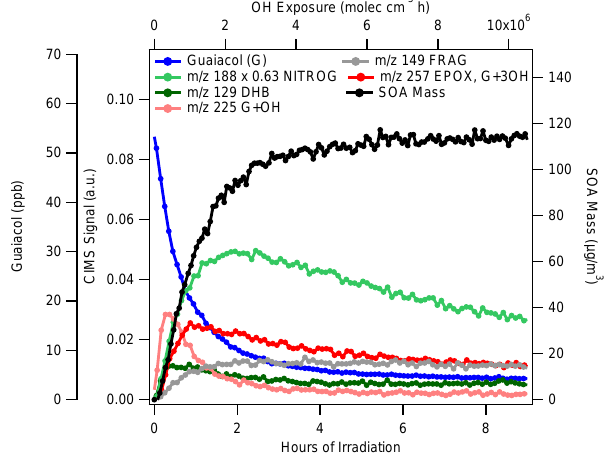
Fig. A1. Guaiacol high-NO x gas-phase and particle-phase develop- ment.